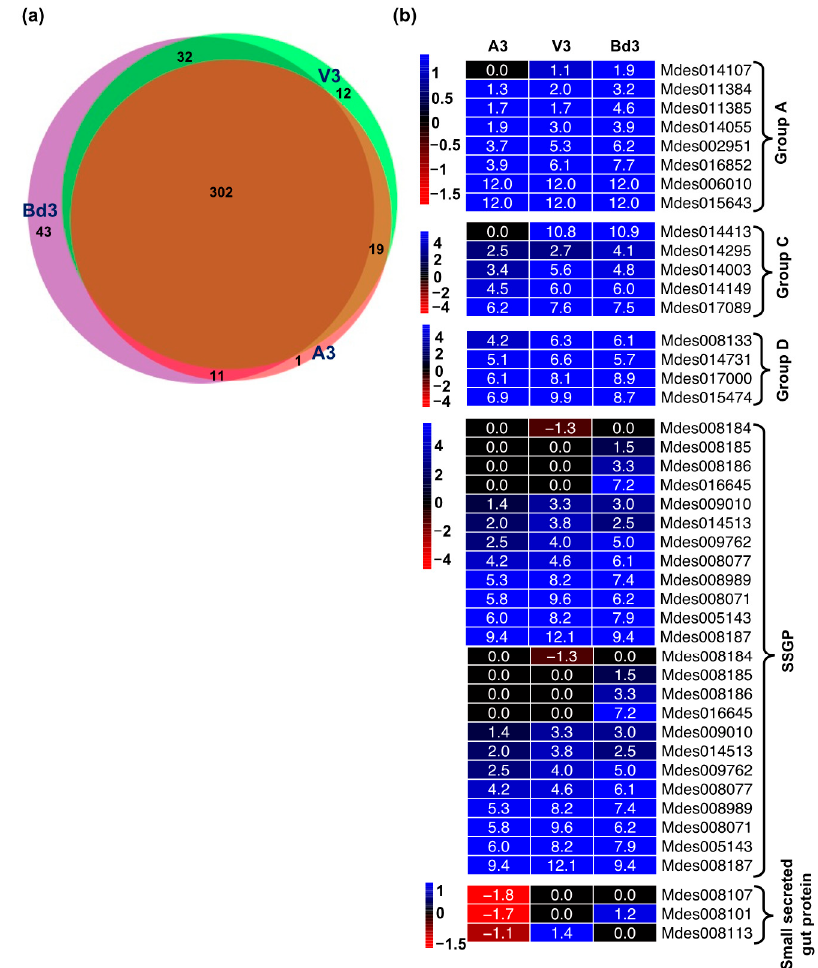
Figure 15. Differential expression of Secreted Salivary Gland Proteins (SSGPs) in Hessian fly larvae 3 days after hatch (DAH). ( a ) Venn diagram showing number of differentially expressed genes encoding SSGPs that are shared and uniquely expressed between A3, V3, and Bd3 larval transcriptomes. ( b ) Heatmaps depicting transcriptional changes in genes representing various SSGP families in A3, V3, and Bd3 larvae. Log2 fold-change RNA-Seq values are shown within each cell of the heatmap. Blue represents up-regulated genes, and red represents the down-regulated genes, while genes not differentially expressed at a particular time-point are indicated in black.